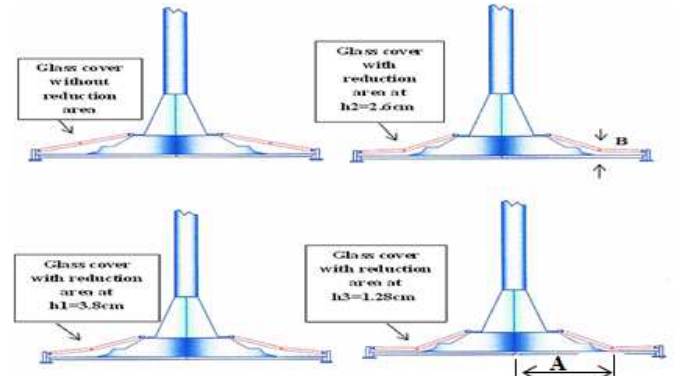
Fig. 7b. Schematic diagram of shape of glass cover for the consider cases